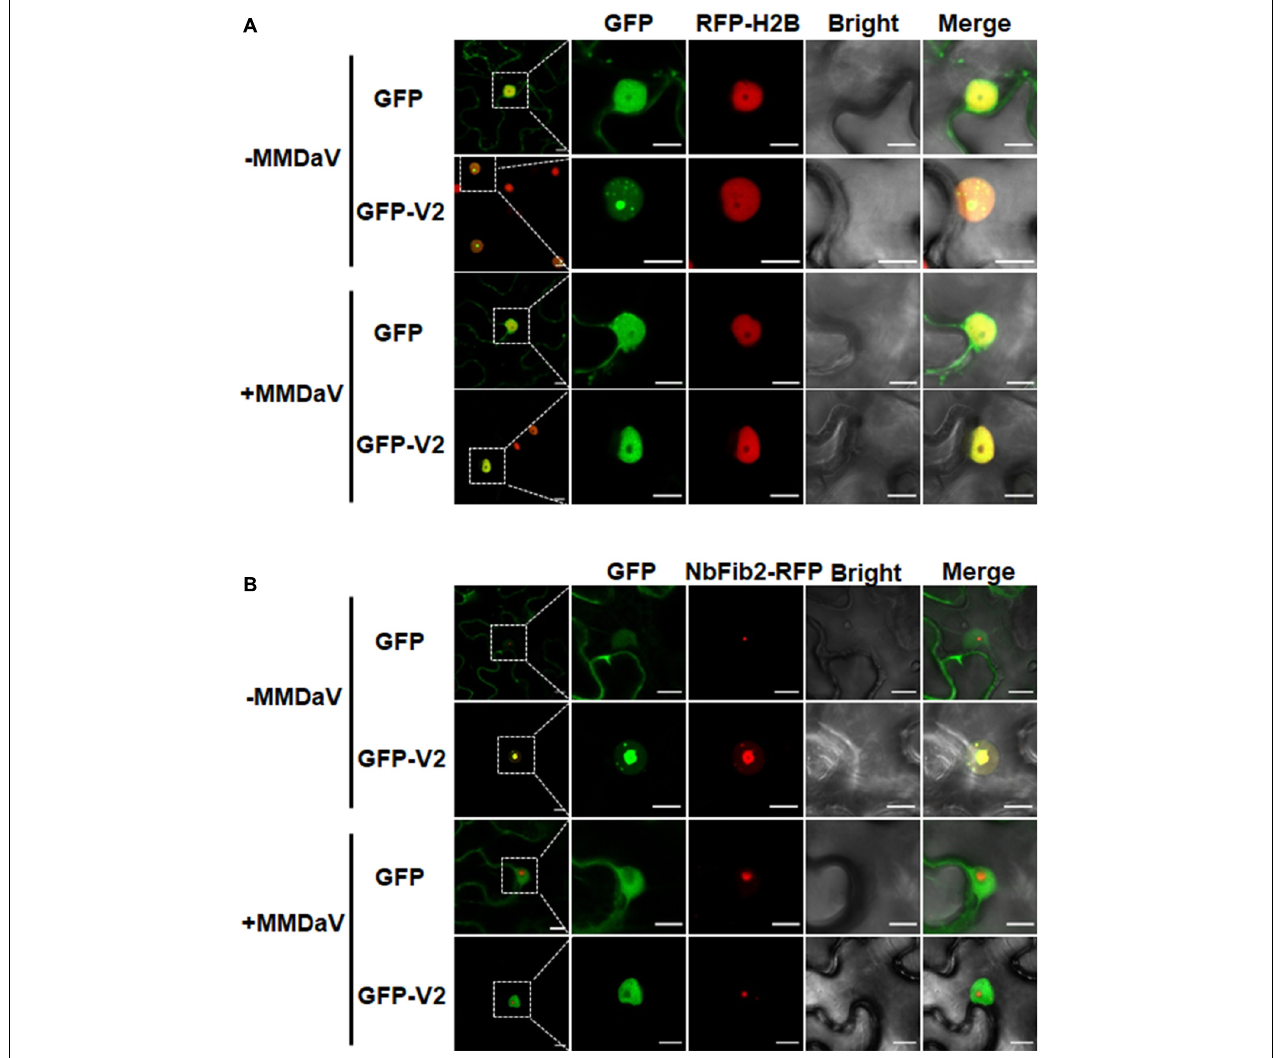
FIGURE 1 | V2 localization within the nucleolus is modulated in the presence of mulberry mosaic dwarf-associated geminivirus (MMDaV). (A) Subcellular localization of green fluorescent protein (GFP) or GFP-V2 fusion in the absence or presence of MMDaV infection in transgenic Nicotiana benthamian a plants expressing red fluorescent protein (RFP)-tagged histone 2B (RFP-H2B). RFP-H2B was used as a nuclear marker. (B) Colocalization analysis of V2 and fibrillarin 2 (NbFib2) in the absence or presence of MMDaV in N. benthamiana plants. To create an environment mimicking MMDaV infection, the infectious clone of MMDaV was infiltrated into RFP-H2B or N. benthamiana leaves 12 h prior to the infiltration of GFP or GFP-V2. Images were taken using Zeiss LSM 880 confocal laser scanning microscope at 36 hours post infiltration (hpi) of GFP or GFP-V2. This experiment was done three times and more than 20 cells were observed per sample and replicate. A representative image is shown for each set. The corresponding region in the white box in column 1 is magnified and shown from Column 2 to Column 5. Scale bars correspond to 10 µ